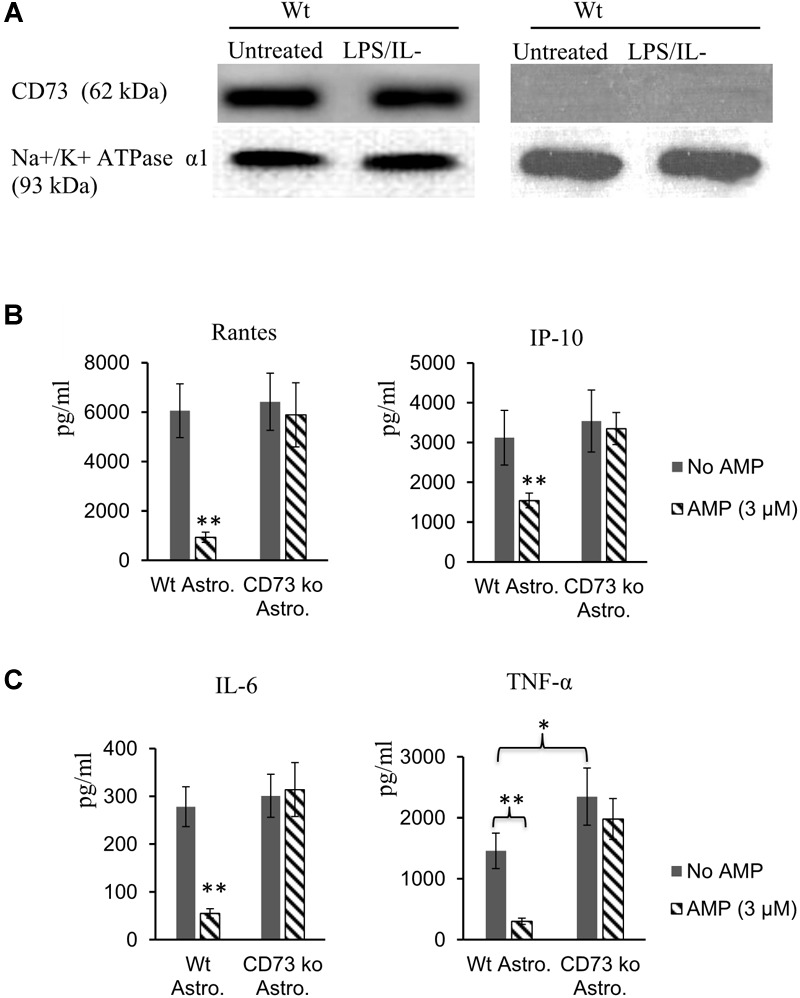
AMP decreases cytokine/chemokine production by wt astrocytes. Astrocytes were purified from the brains of wt and CD73-/- mice, cultured in vitro and treated with LPS (100 ng/ml) plus IL-1β (10 ng/ml), with or without the addition of 5′-AMP (3 μM). Cytokine and chemokine levels in the supernatant were detected by ELISA 2 days later. CD73 levels in the cells before and after the treatment were detected by Western blotting. ∗∗Indicates statistically significant differences (p < 0.01). (A) CD73 levels in wt and CD73-/- astrocytes were detected by Western blotting with Na+/K+-ATPase as the reference. (B) RANTES and IP-10 levels in the medium were determined by ELISA (n = 6). (C) IL-6 and TNF-α levels in the medium were determined by ELISA (n = 6).